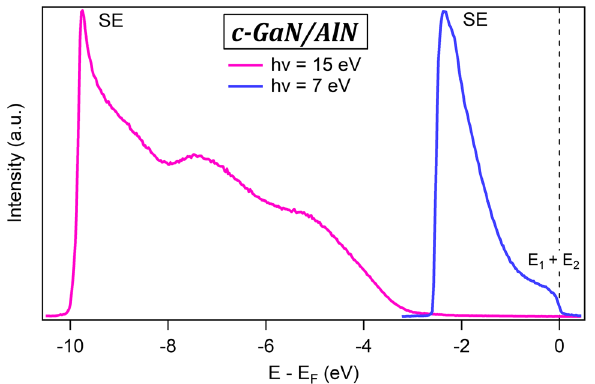
Figure 3. Angle-integrated ARPES intensity measured from the c-GaN/AlN system with photon energy hv = 7 eV and hv = 15 eV. The energy scale is referenced to the Fermi energy E F